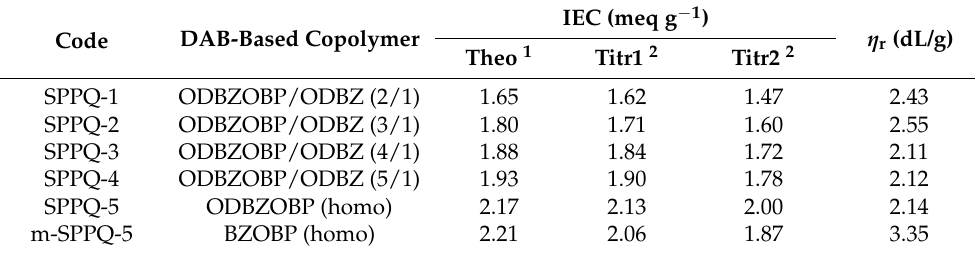
Table 1. IEC and viscosity of SPPQs.